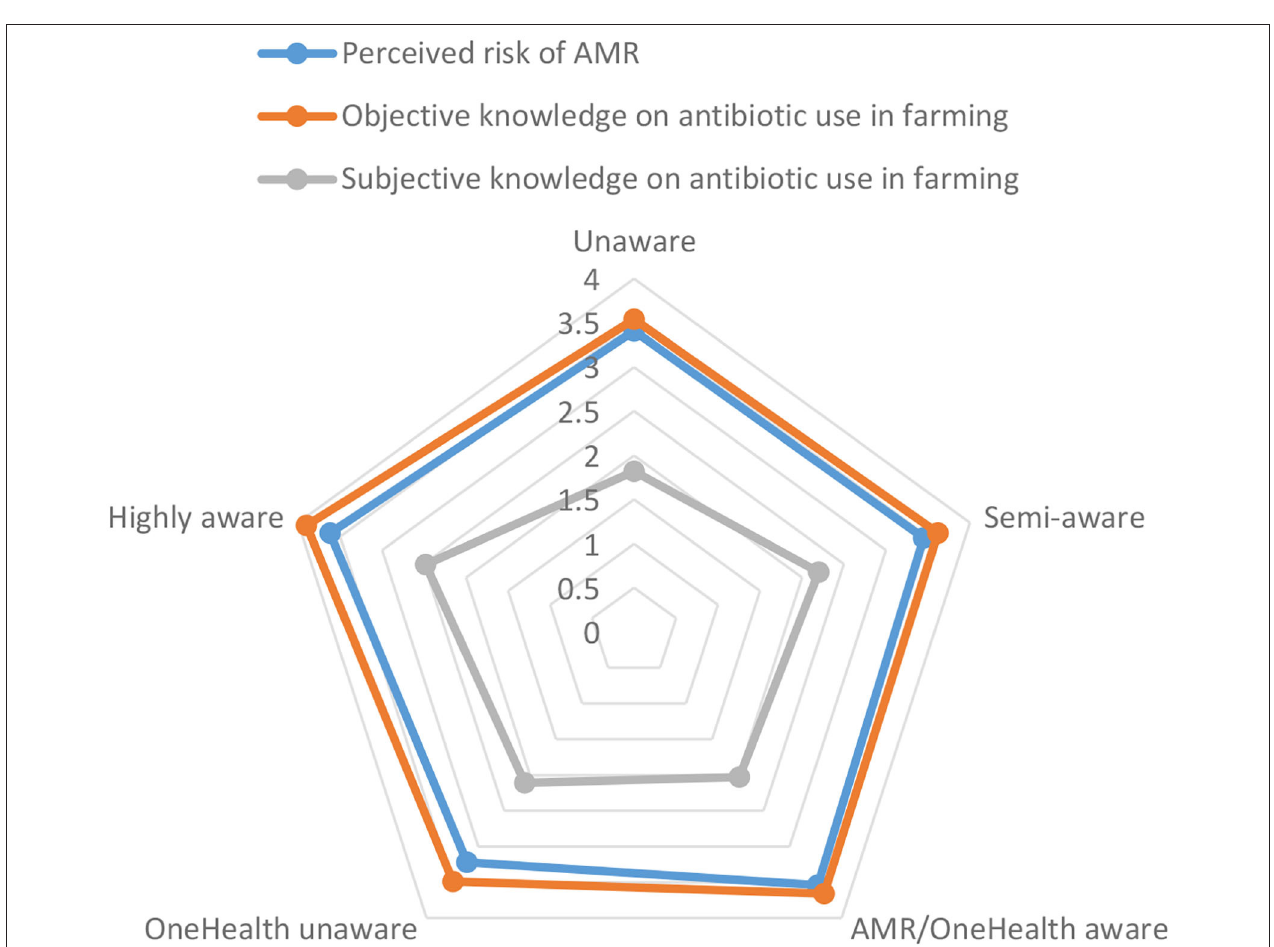
FIGURE 1 | Agricultural antibiotic knowledge levels and AMR risk perceptions across five clusters of consumers, categorised based on perceived impact of Covid-19 on awareness of AMR, OneHealth, and welfare information on labels ( n =